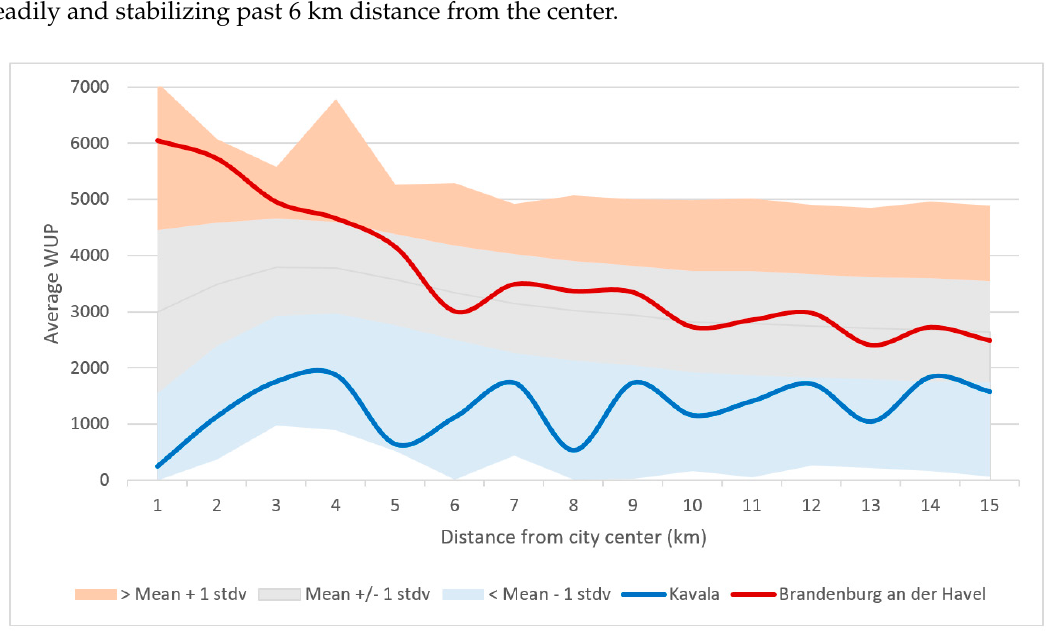
Figure 16. WUP profile for the urban area around the cities of Kavala, Greece 8 km in blue, and Brandenburg an der Havel, 6 km in red. The faint grey line represents the average WUP across all EU cities, the blue area represents zones with average WUP values inferior to the mean by more than one standard deviation, and the area in red represents zones with average WUP values superior to the mean by more than the standard deviation.